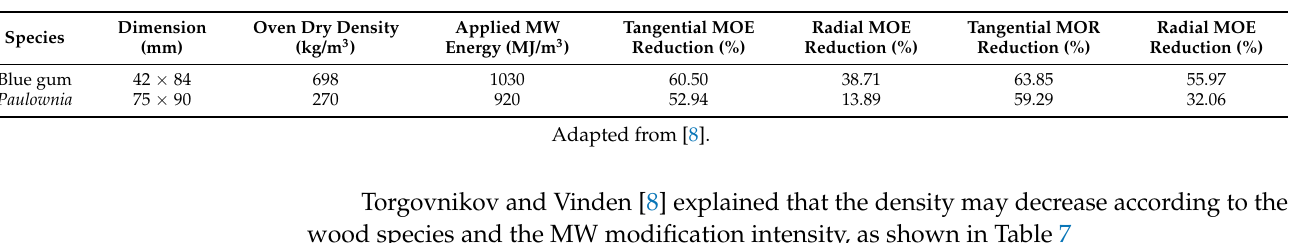
Table 6. MOE and MOR reduction of blue gum and Paulownia woods found by [8].